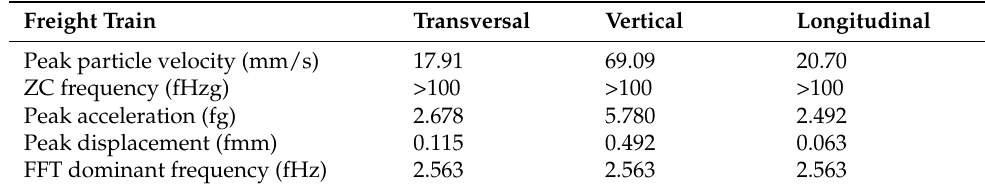
Table 6. Calibrated measurement results from Minimate Plus measuring equipment for Passenger Train .